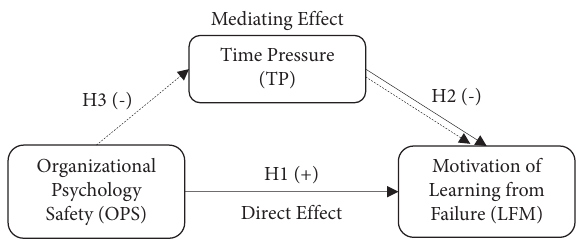
Figure 1: Conceptual Framework. Note: The mediating effect of time pressure is indicated by dashed lines